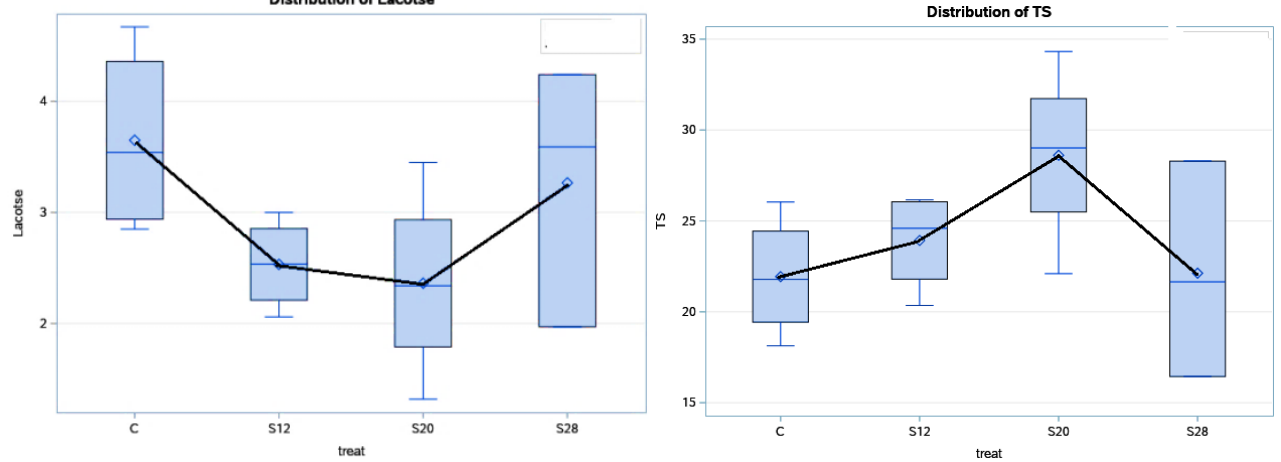
Figure 3. The effect of dietary treatment on the colostrum total solid and lactose contents at 48 h. Figure 4 highlights the effect of time (three and 48 h postpartum) on the colostrum